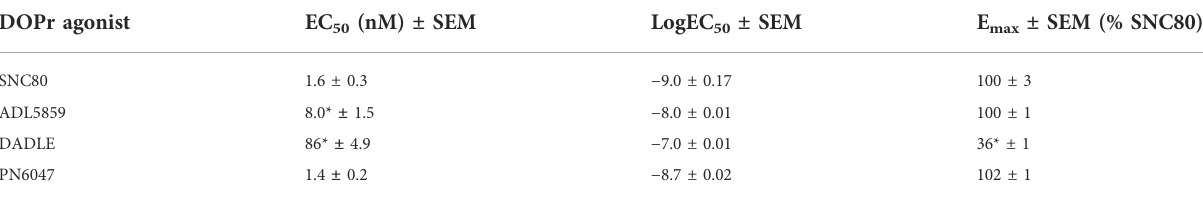
TABLE 1 Estimates of EC50, logEC50, and Emax obtained from fi tting the three-parameter sigmoid curve.